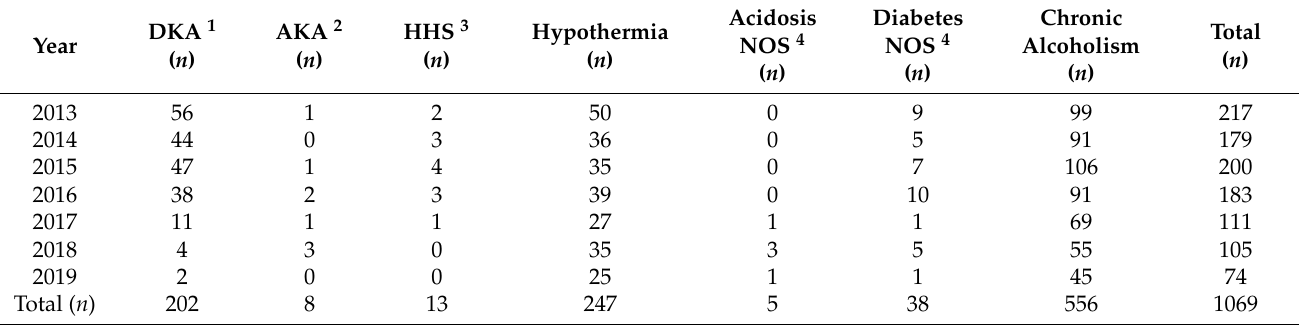
Table 2. Other cases (not analysed for BHB) per year.